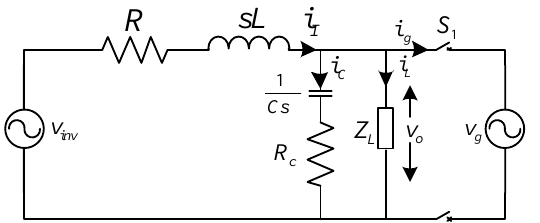
Figure 2. Simplified network of three-phase grid-connected distributed generation unit.